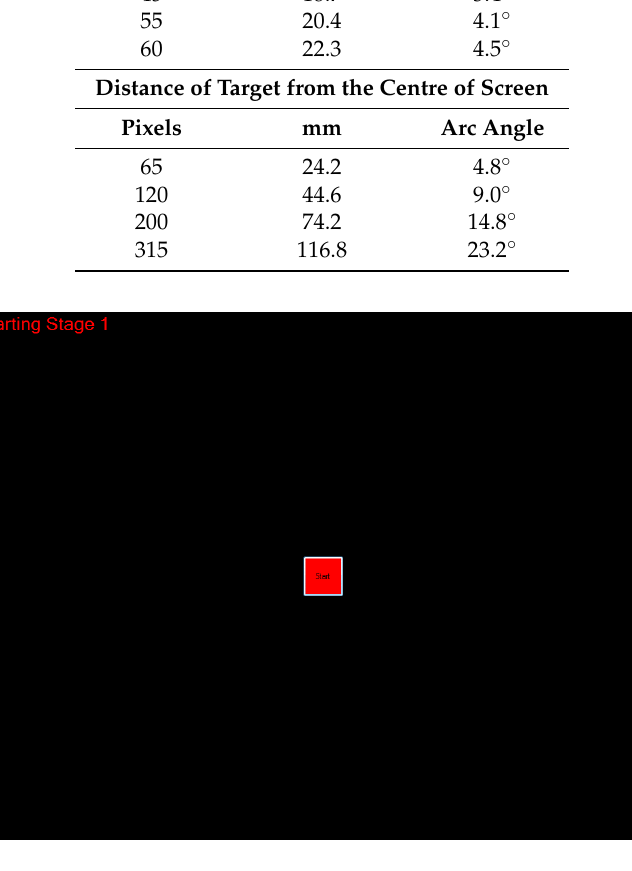
Figure 20. Screenshot at the beginning of the task.